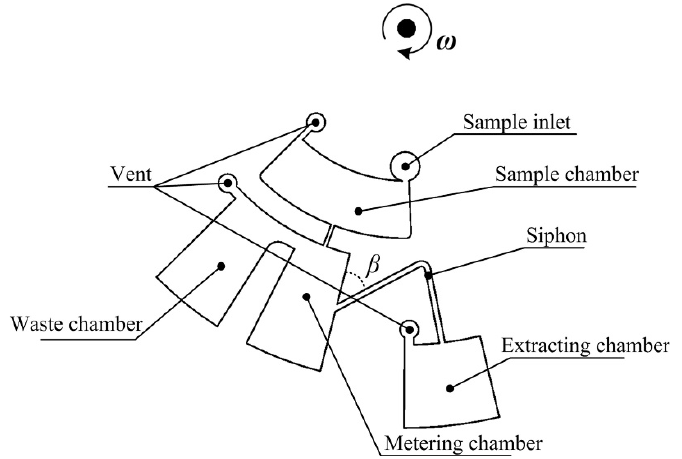
Figure 4. Schematic of the Euler siphon valve on a CD microfluidic chip, where β is the inclination angle of the siphon channel. Source: Reconstructed from publication cited [24]. Permission granted by the publisher.